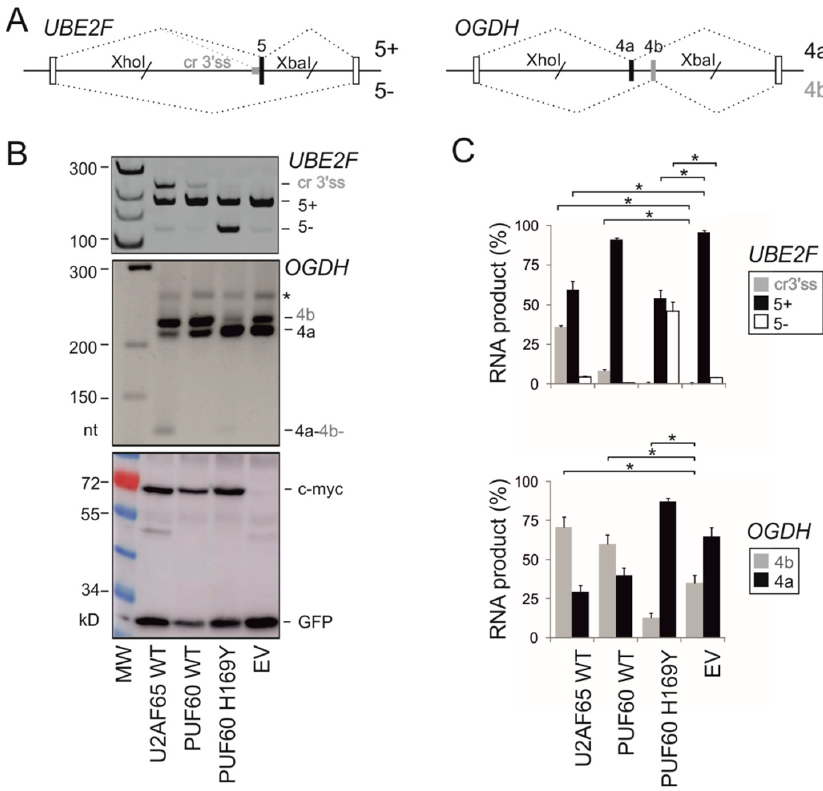
Figure 1. Altered exon usage of PUF60-dependent exons by U2AF65. ( A ) Schematics of PUF60-dependent hybrid reporter constructs. Their wild-type sequences are in Figure S1. Exons are shown as boxes, introns as horizontal lines, spliced products as dotted diagonal lines above and below the pre-mRNA. Designation of the spliced products is to the right. Grey horizontal rectangle denotes the (T) n G repeat of the canonical 3 ′ ss PPT [14] , slashes denote restriction sites used for cloning and empty boxes represent heterologous exons, as described [25] . ( B ) UBE2F and OGDH splicing patterns in cells